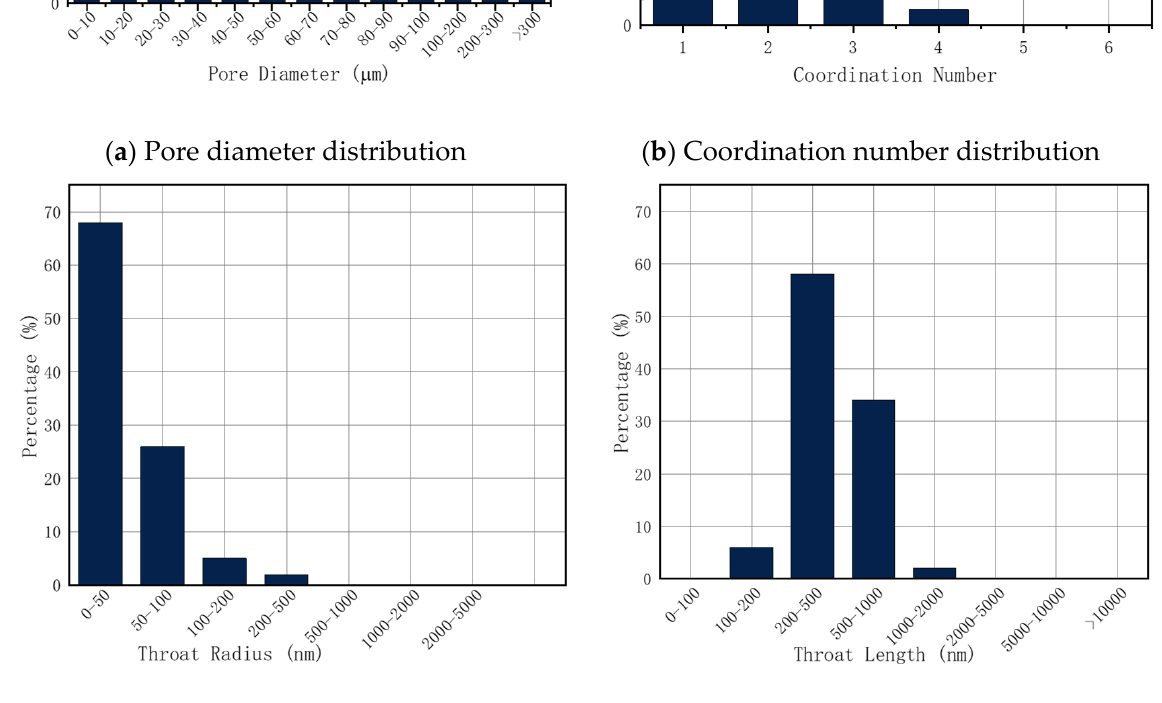
Figure 14. Distribution of structural characteristics of CZ-Y47-1.